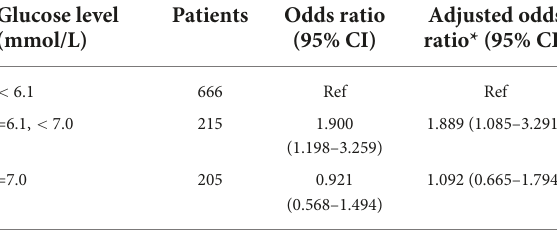
TABLE 4 Fasting glucose levels categorized by diabetes mellitus diagnosis according to World Health Organization criteria (WHO/IDF 2019) and the risk of a first DVT